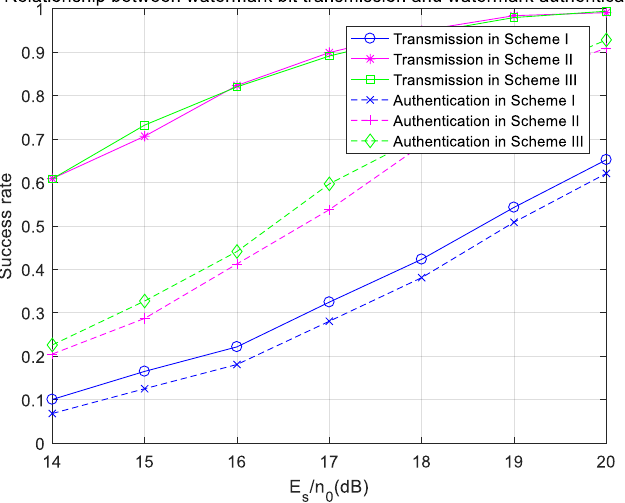
Figure 19. Success rates of watermark-bit transmission and watermark authentication under ideal synchronization in the fading channel.